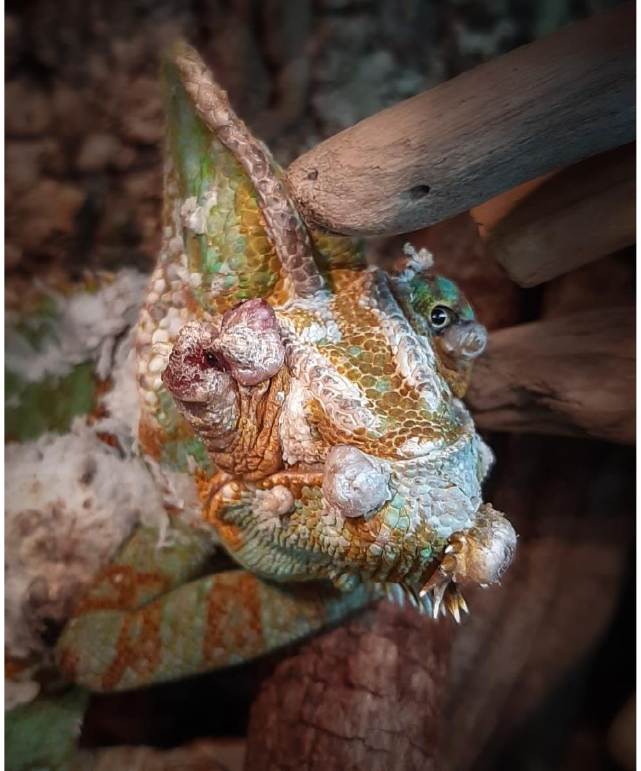
Figure 3. Macroscopic multicentric nodular, crateriform dermal lesions located at the head, including both eyelids, in a veiled chameleon ( Chamaeleo calyptratus ).